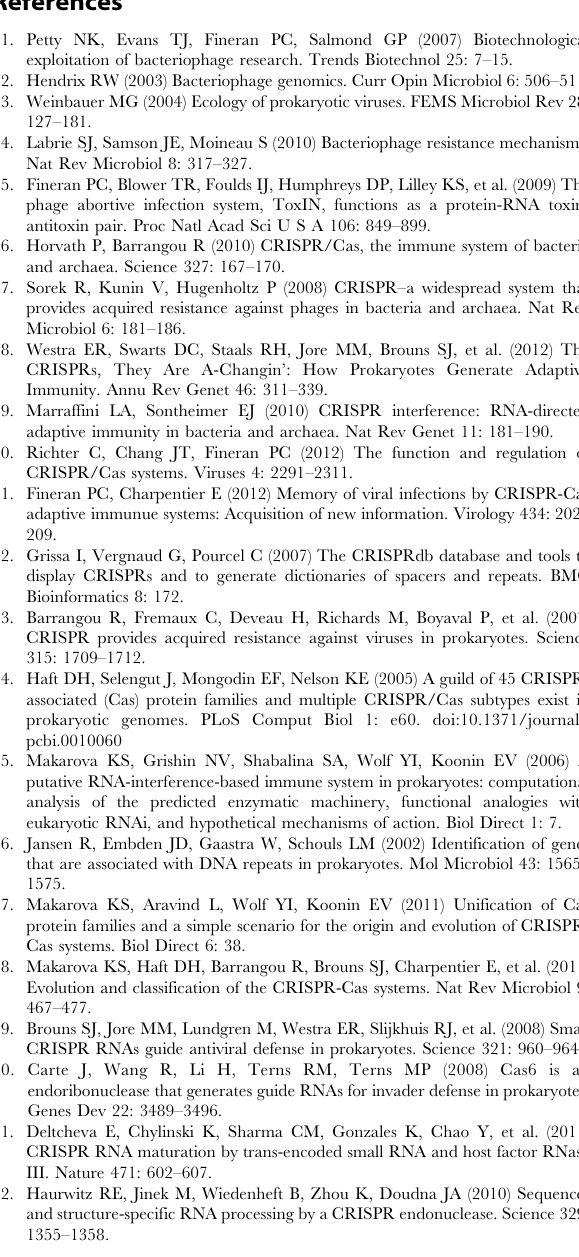
Table S1 CRISPR spacers used in this study. (PDF) Table S2 Bacterial strains and bacteriophage used in this study. (PDF) Table S3 Plasmids used in this study. (PDF) Table S4 Oligonucleotide primers used in this study.